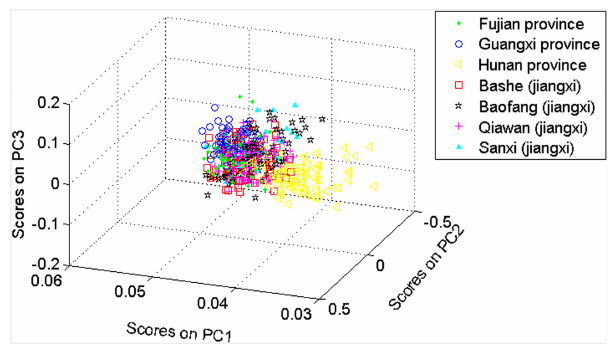
Fig. 3. Three-dimensional scores plot from PCA of raw NIR spectra for calibration samples.